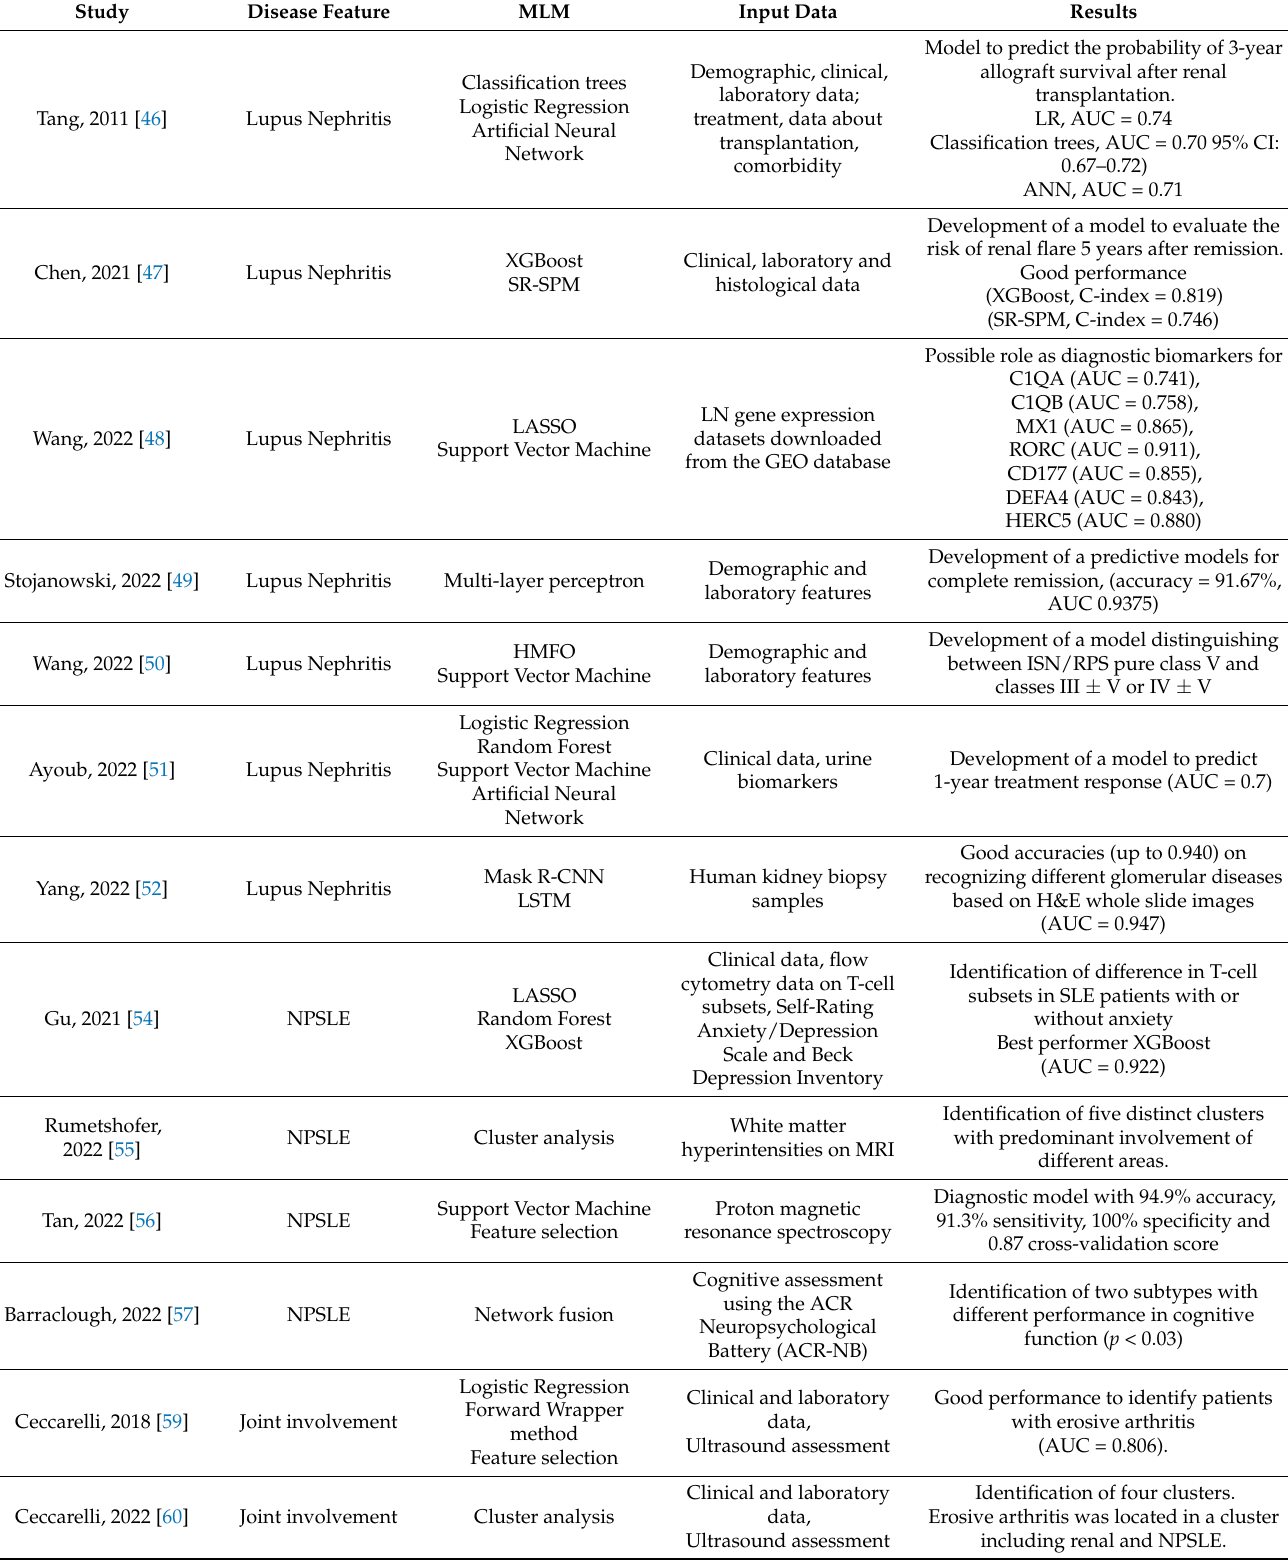
Table 2. Data about studies applying Machine Learning Models in different disease-related features, in particular Lupus Nephritis, Neuropsychiatric SLE, joint